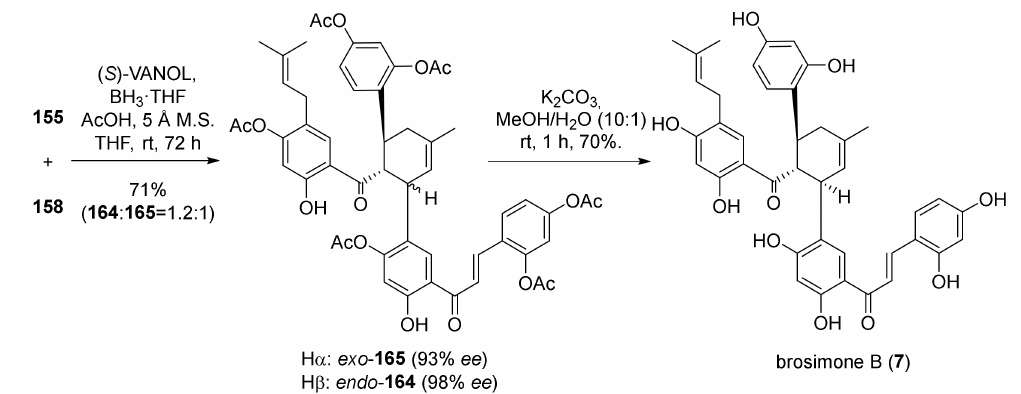
Figure 54. Enantioselective synthesis of brosimone B ( 7 ).